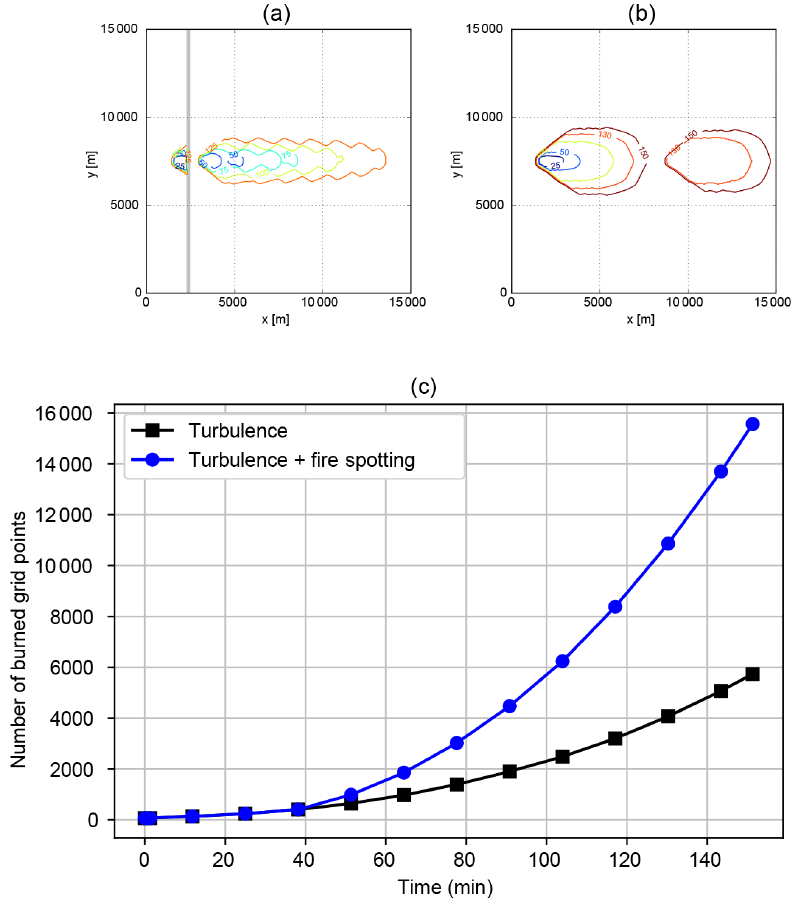
Figure 4. (a) Line contours showing the fire perimeter at different time steps with the presence of a fire barrier. The wind velocity is 10ms − 1 , the fire intensity is 25MWm − 1 and the diffusion coefficient is 0 . 15m 2 s − 1 . The x and y axes of the plot are scaled by a factor of 4. The same plot is proposed in (b) , but with U = 20ms − 1 and no barrier. (c) A comparison of the total burned area at different time steps when only turbulence is considered (black) and when both turbulence and fire spotting are included (red). The total burned area is simply the number of burned grid points at any each instant. For both line plots, the wind velocity is 10ms − 1 , the fire intensity is 25MWm − 1 and the diffusion coefficient is 0 . 15m 2 s − 1